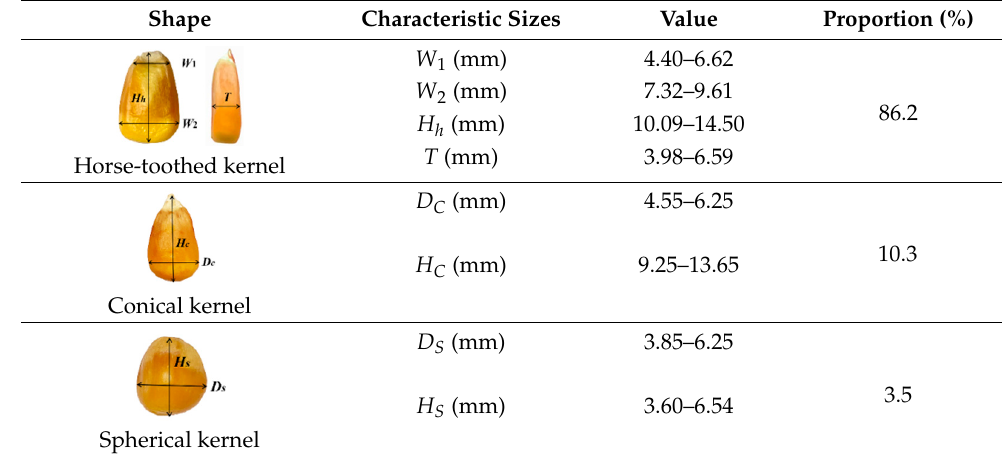
Table 2. Particle size distribution of corn kernels.